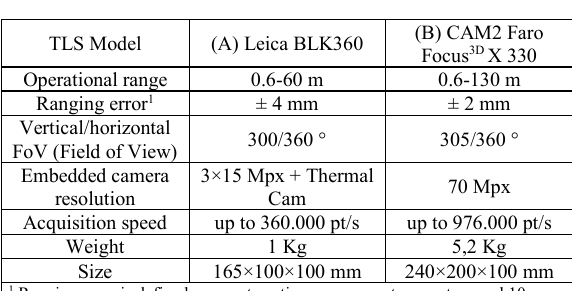
Figure 8. Leica BLK360